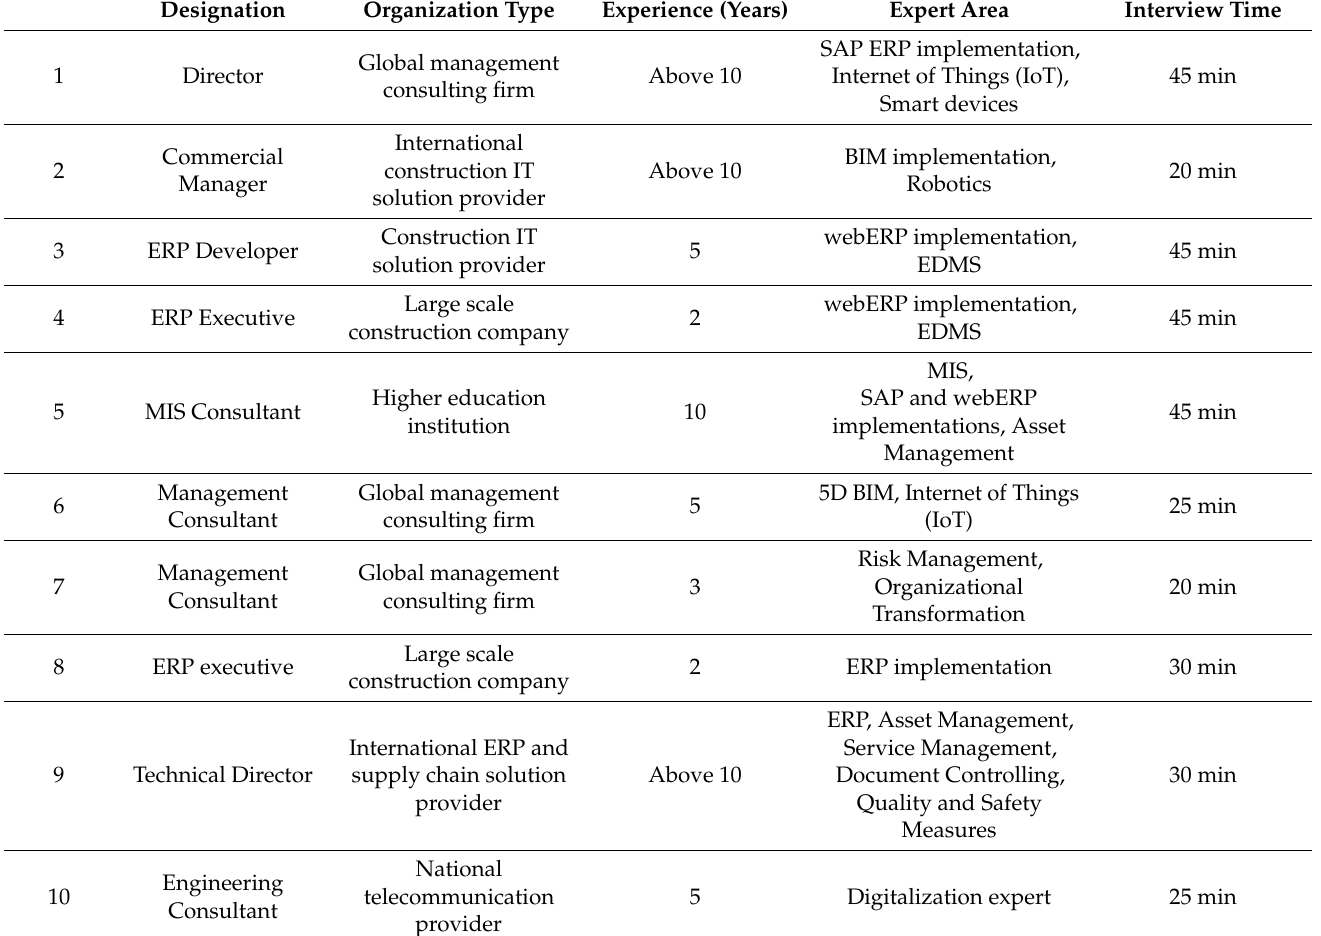
Table 1. Expert interview